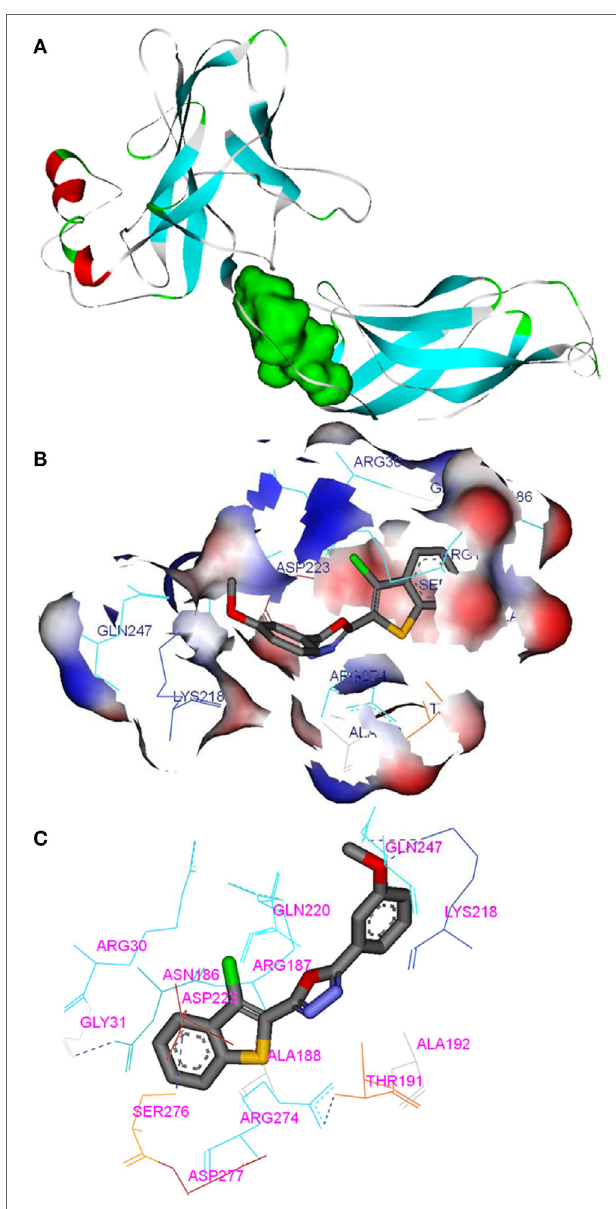
FigUre 6 | In silico molecular interactions between p65 of NF- κ B complex and the oxadiazole derivatives: (a) hydrophobic region of p65 was shown as green mass; (B) surface view of CMO bound p65 with the key amino acids (labeled); (c) interaction map and hydrogen bonding (dotted line) pattern of p65 protein with